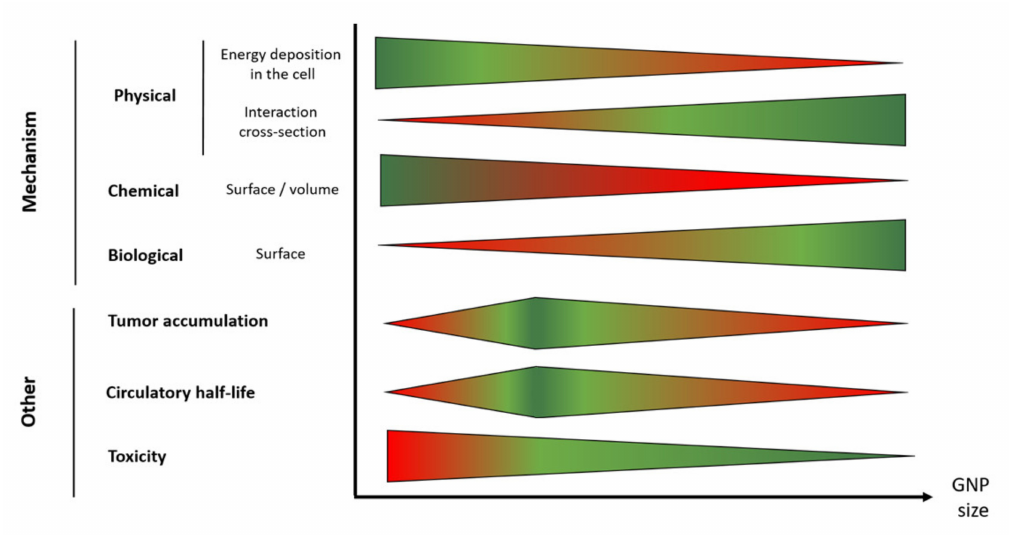
Figure 5. Schematic representation of the e ff ect of GNP size on di ff erent factors involved in the radiosensitization e ff ect. The triangle shows the evolution of the studied parameter as a function of the GNP size. The color refers to the action of this parameter on the radiosensitization e ff ect (green = positive / will increase it; red = negative / will decrease